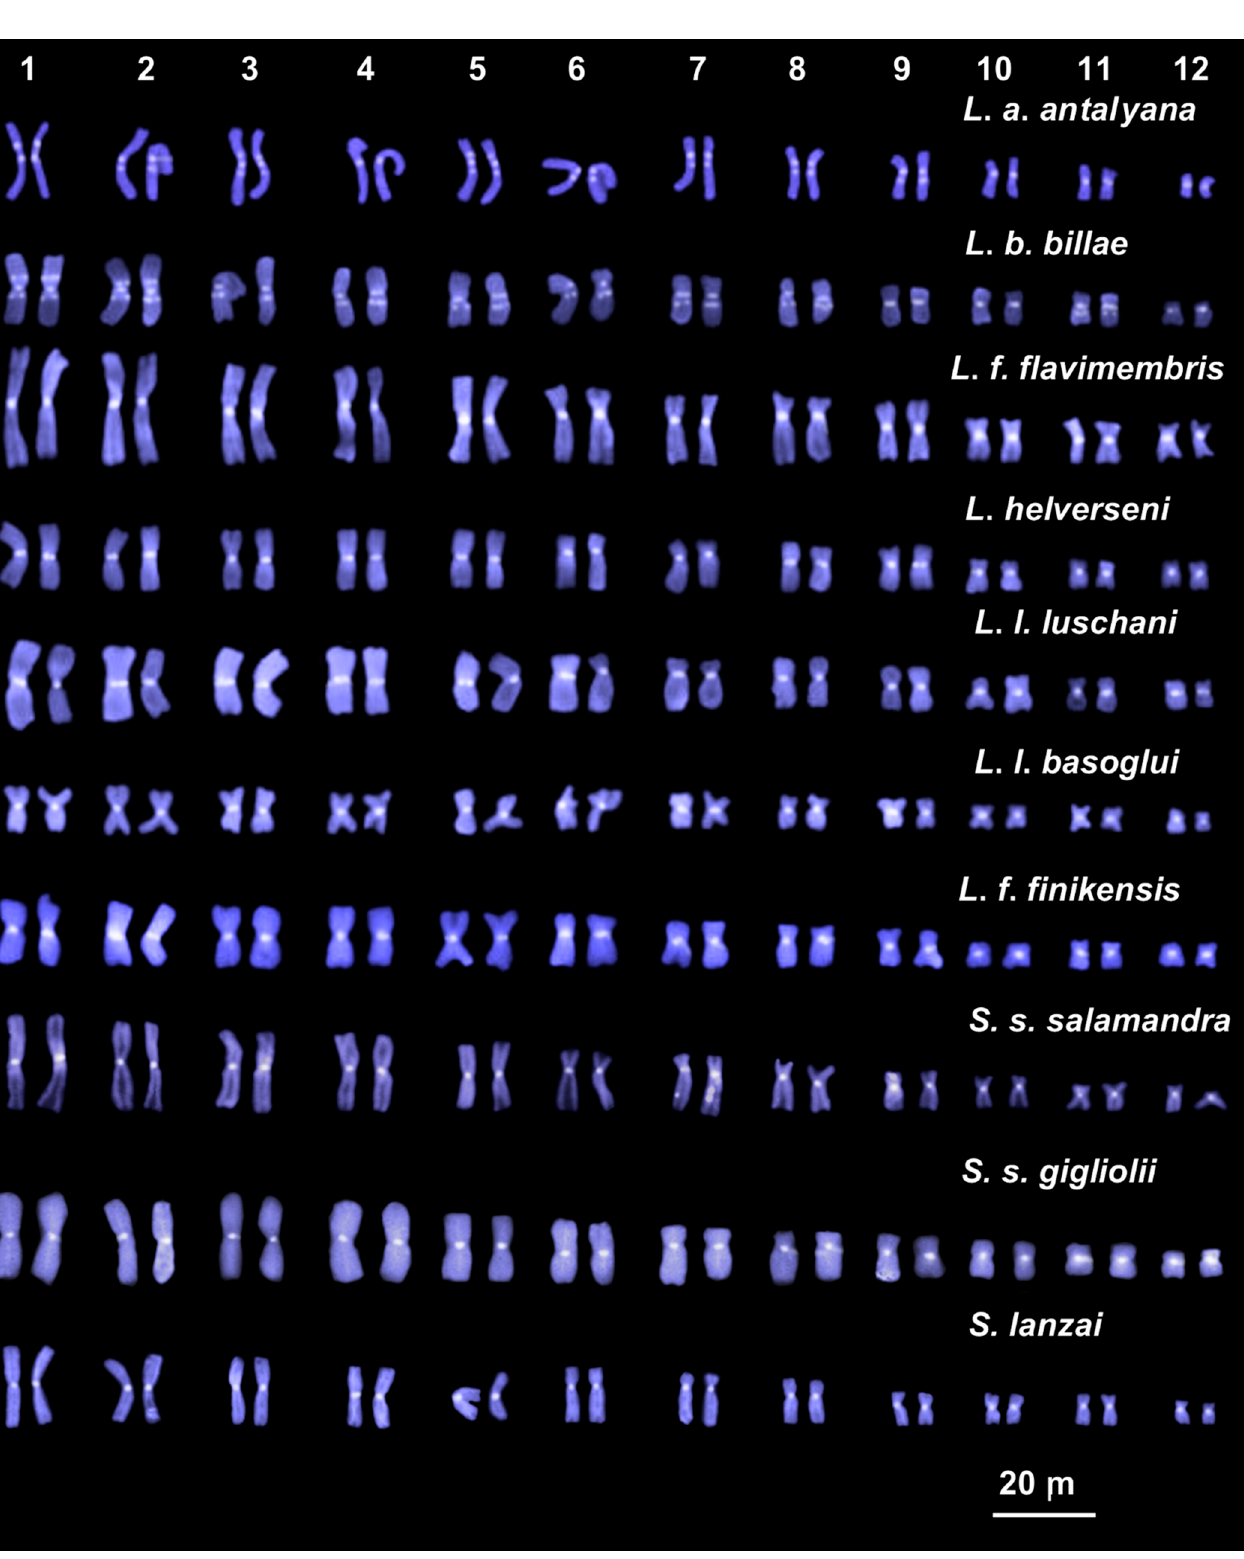
Figure 4. C-banding + DAPI-stained karyotypes of the examined taxa of Lyciasalamandra and Salamandra .